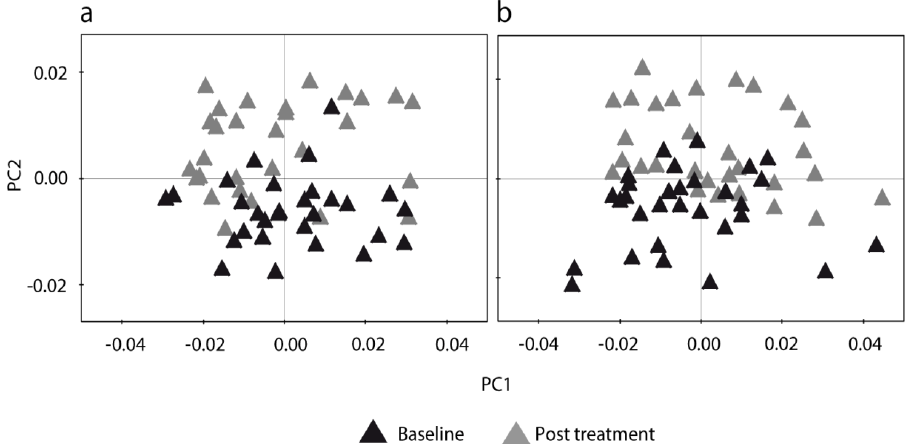
Figure 2. PCA score plot of baseline and post treatment samples ( a ) GDL acidified